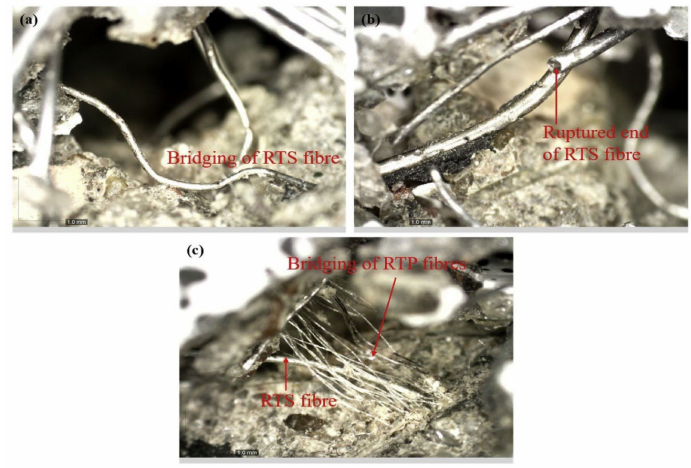
Figure 10. Images of the fiber–matrix interaction taken via optical microscopy